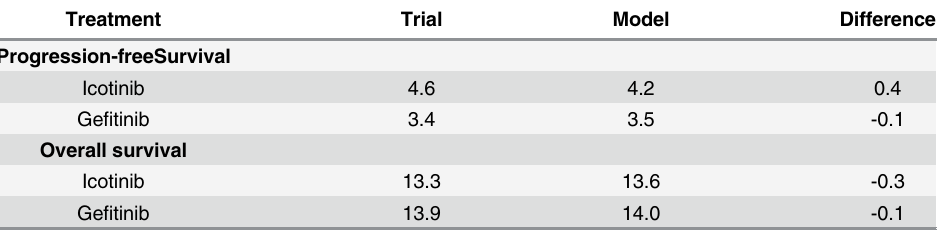
Table 2. The median survival time of icotinib and gefitinib as second-line therapy for advanced NSCLC patients.